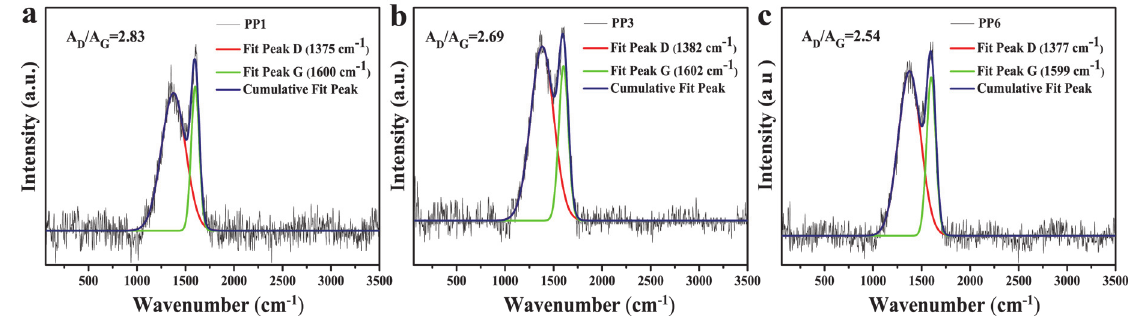
Figure 9. Raman spectra of char residues of PP1 ( a ), PP3 ( b ), PP6 ( c ) after CCT.